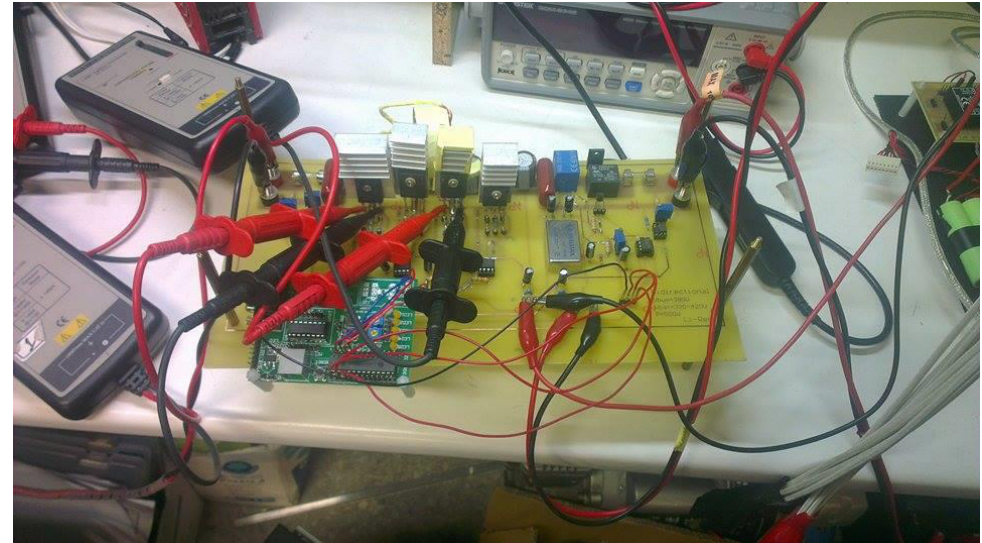
Figure 26. Picture of the implemented universal bidirectional DC-DC converter.